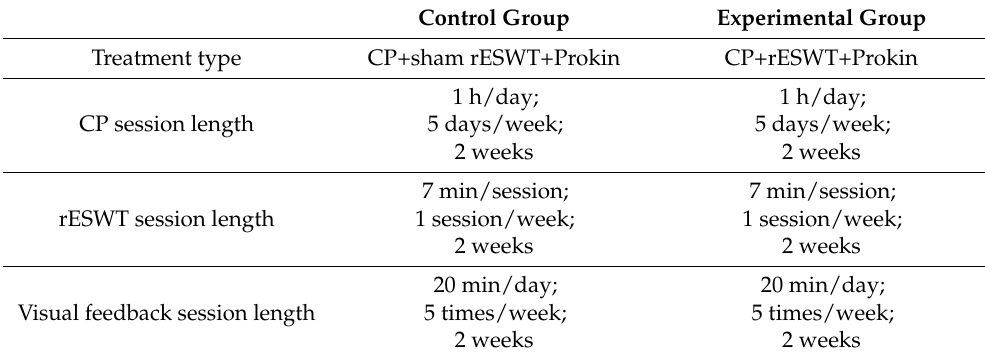
Table 1. Therapeutic interventions and parameters for the control group and the experimental group. Control Group Experimental Group Treatment type CP+sham rESWT+Prokin